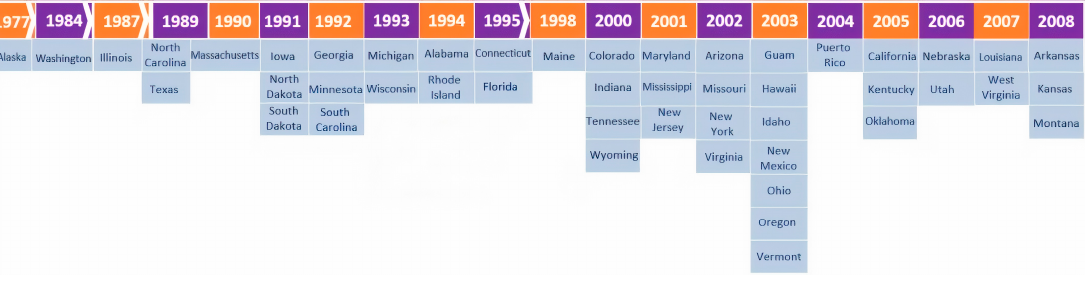
Figure 1. Timeline of congenital adrenal hyperplasia (CAH) newborn screening implementation in the United